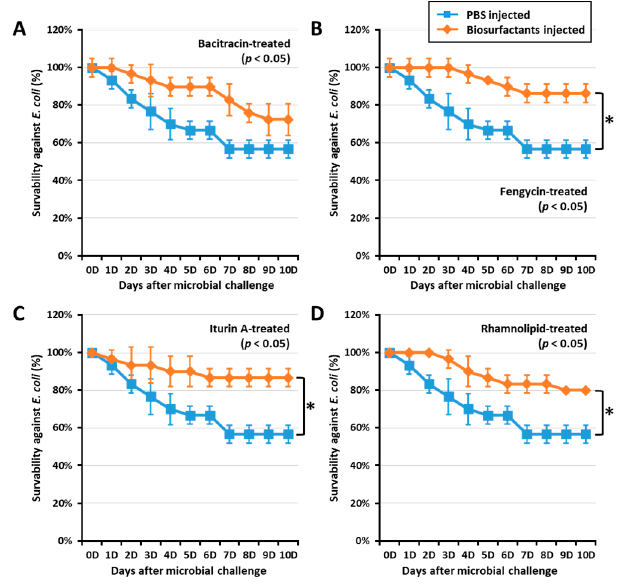
Figure 3. Effect of biosurfactants on T. molitor larvae survivability against E. coli . T. molitor larvae survivability against E. coli was assessed by challenging with E. coli (10 6 CFU / µ L) 24 h post immune activation by biosurfactants such as bacitracin ( A ), fengycin ( B ), iturin A ( C ), and rhamnolipid ( D ).